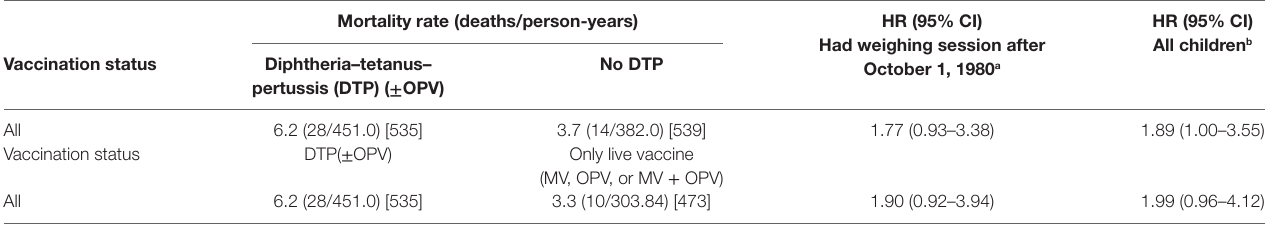
TaBle 4 | Analysis 3: mortality rates (MR) per 100 person-years and hazard ratios (HR) of 6–35 months old children in relation to most recent vaccination.